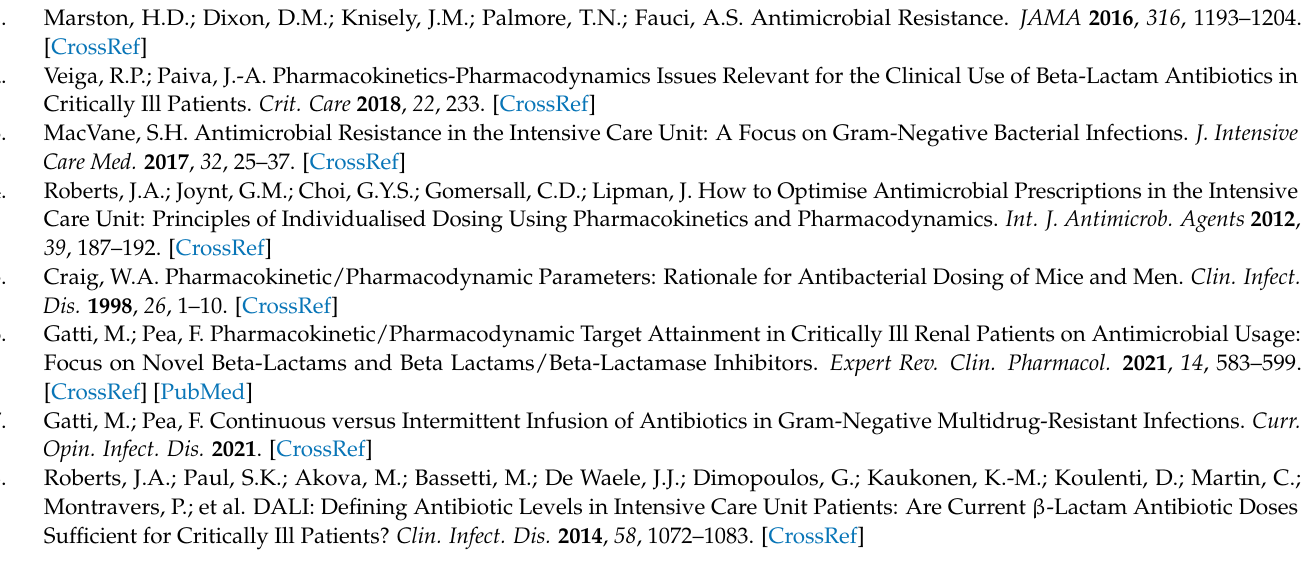
Table S2: Demographics and clinical features of patients with Gram-negative infections showing microbiological failure or resistance